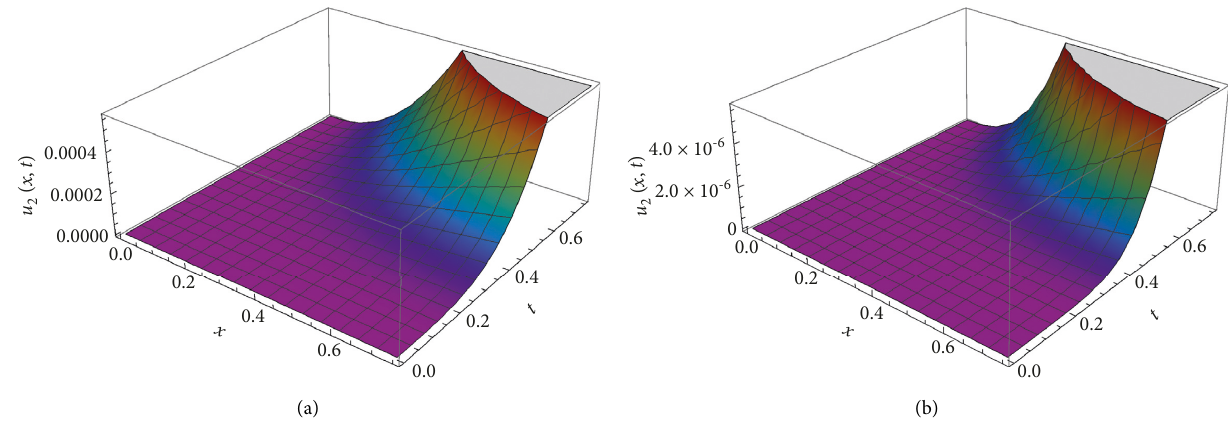
Figure 2: The graphs of the second-order iterative solution u ( x,t ) for (25) through various values of x,t at α � 0 . 5 , 1, respectively. (a) The graph of the second-order iterative solution for (25) through various values of x, t at α � 0 . 5. (b) The graph of the second-order iterative solution for (25) through various values of x, t at α �